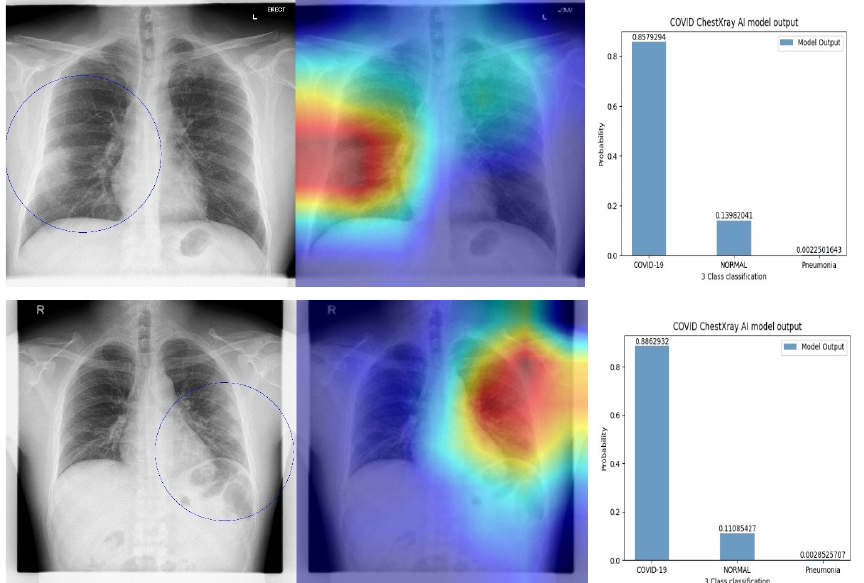
Figure 4. Examples of heatmaps and predictions generated by the AI model. The left-most image displays grayscale chest radiographs with superimposed blue circles indicating the suspicious area showing signs of possible COVID-19 infection based on the AI model’s heatmaps. The middle image shows the heatmaps overlaid on the original CXRs, with the highlights indicating the anatomical regions that contribute most to the final model predictions. The right-most image displays the predicted probabilities for each